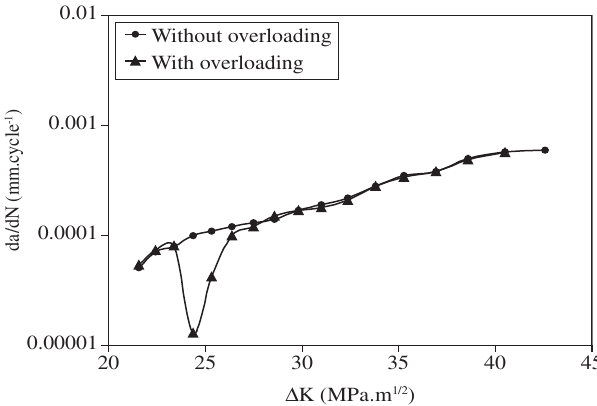
Figure 2. da/dN vs. ∆ K for AW microstructural condition after an overload of 16.2 kN.